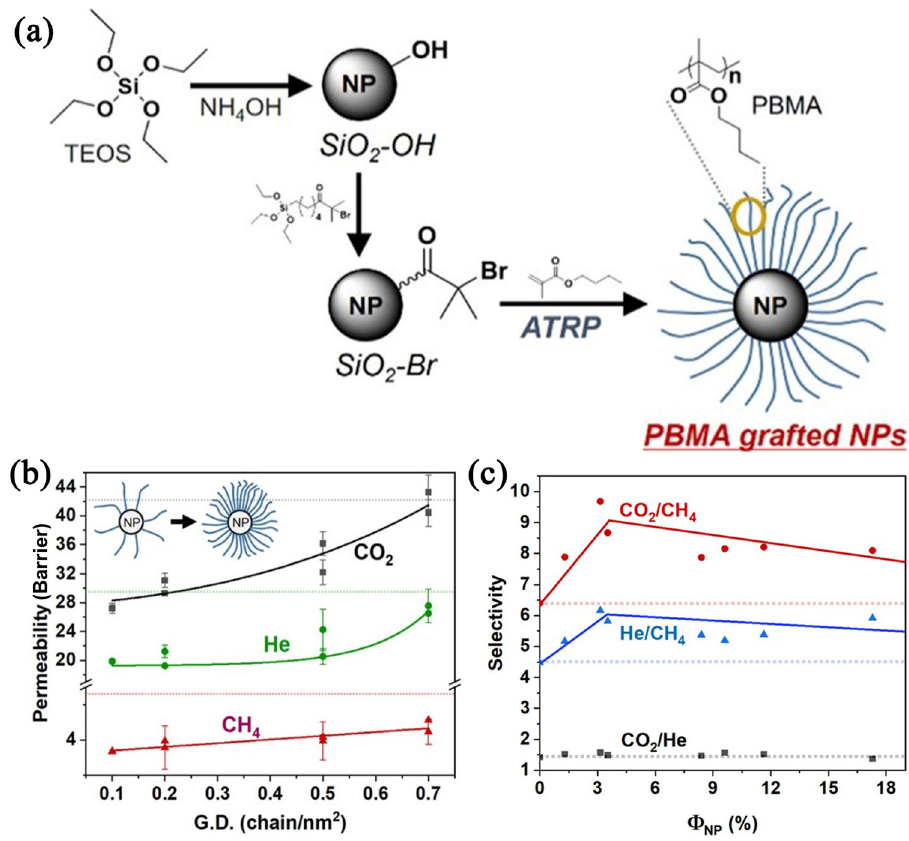
Figure 27: ( a ) PBMA grafting process of nano - SiO 2 , ( b ) relationship between SiO 2 graft density and gas permeability, and ( c ) gas selectivity of PBMA PGN fi lms as a function of SiO 2 volume fraction [ 177 ] ; Copyright: 2021 with permission from